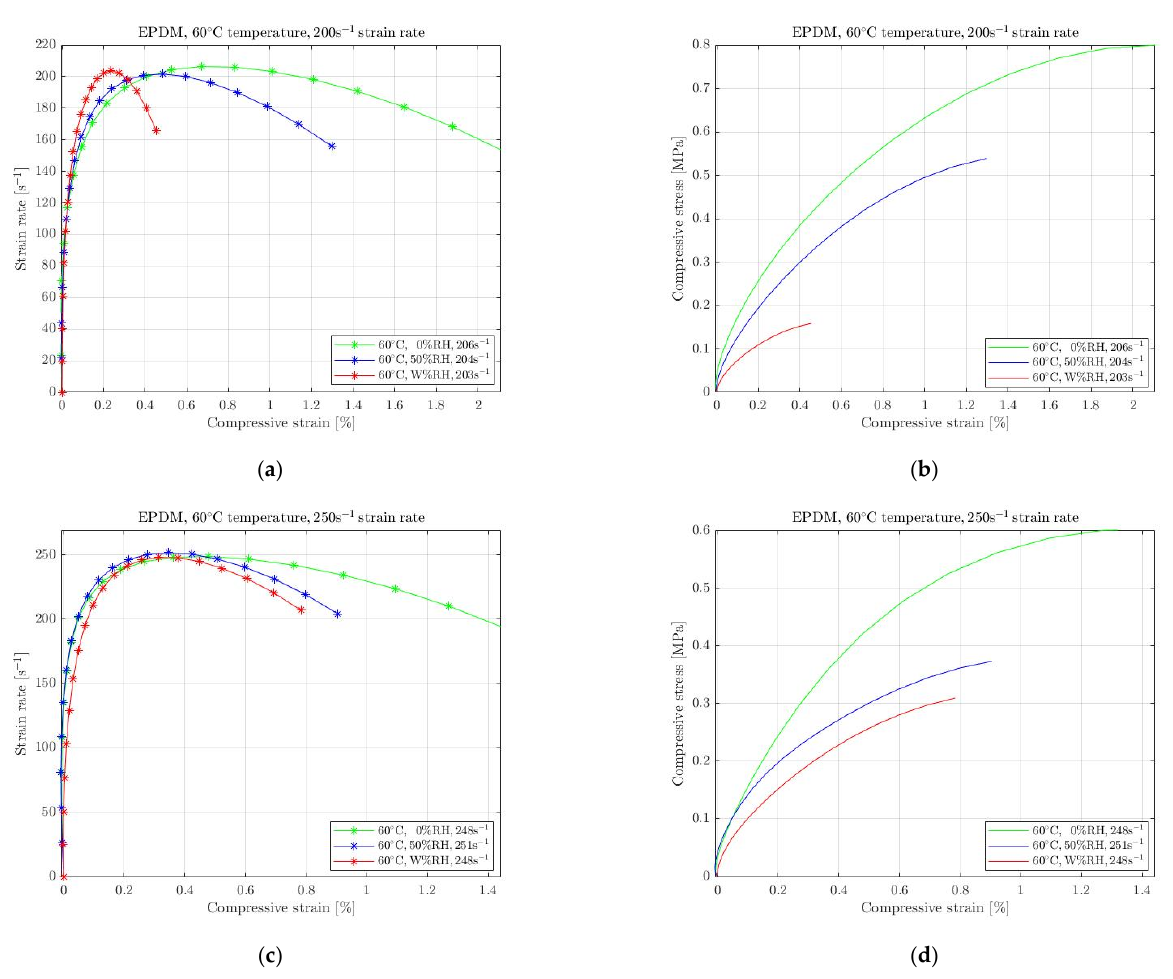
Figure 13. Strain rate vs. compressive strain ( a , c ) and compressive stress vs. compressive strain ( b , d ) of EPDM under compression at 60 °C temperature with 0%, 50% and W% RH for 200 s − 1 ( a , b ) and 250 s − 1 ( c , d ) strain rate.